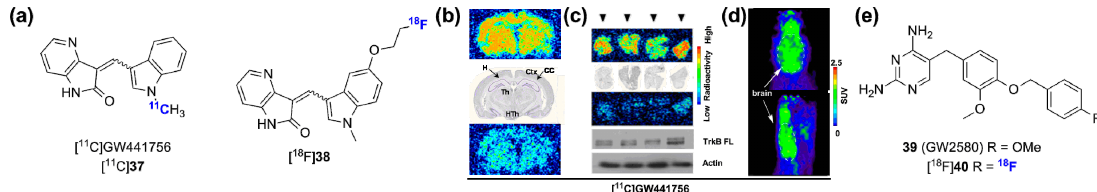
Figure 12. Trk radiolabeled inhibitors. ( a ) Chemical structures of [ 11 C]GW441756 and [ 18 F] 38 ; ( b , c ) In vitro validation of [ 11 C]GW441756 using rat brain and TrkB-expressing human neuroblastoma cryosections (reprinted with permission from [134] © 2015 American Chemical Society); ( d ) PET images of [ 11 C]GW441756 in the rat brain; ( e ) Chemical structure of [ 18 F] 40 . Molecules 2015 , 20 , page–page